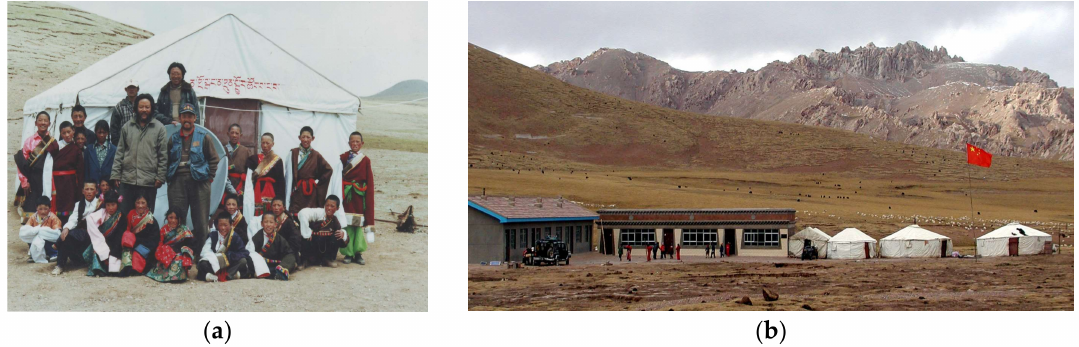
Figure 7. The Muqu village tent school was established circa 2000, shown here ( a ) with first intake of students and ( b ) in its final location, including permanent buildings, with prime snow leopard habitat in the